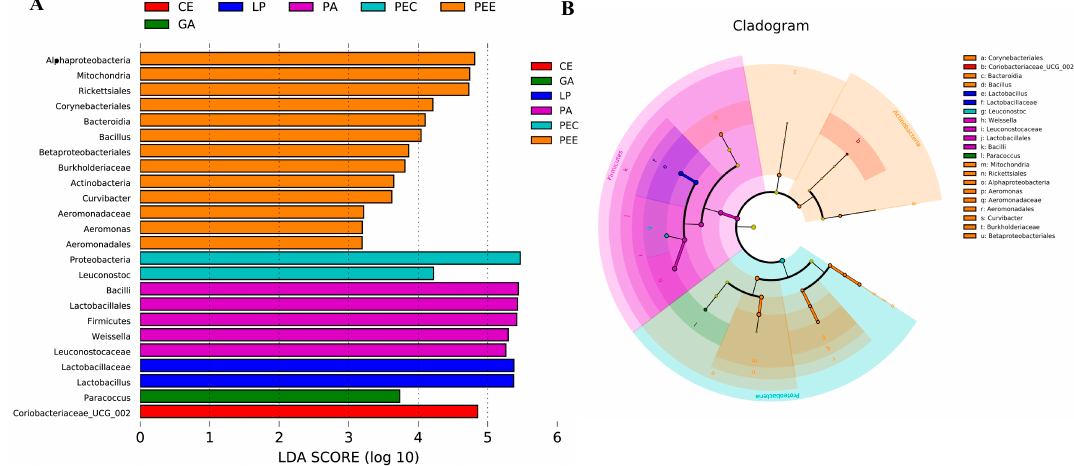
Figure 4. The core specific bacterial biomarker. LEfSe (Linear discriminant analysis Effect Size) analysis shows differentially abundant bacteria communities across the six additives groups as biomarkers determined using the Kruskal-Wallis test ( p < 0.05) with a linear discriminant analysis (LDA) score >3.0 ( A ). This cladogram is color-coded; in brief, the orange bars, for example, represent the bacteria with the highest abundance in pectinase (PEE) compared with those in the other groups. It shows a representation of the differentially abundant bacteria (highlighted by small circles and by shading) among the six additives groups ( B ). There are six layers from the inside of this plot to the outside, corresponding to six levels of the taxonomy (kingdom, phylum, class, order, family, and genus). The size of each node represents their relative abundance.